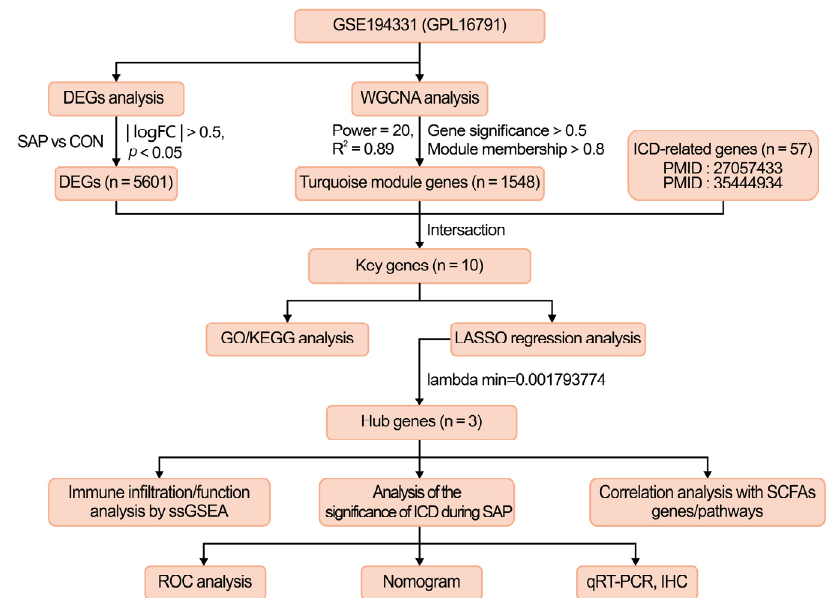
Figure 10. The study flowchart of the whole experiment. GSE, gene expression omnibus series; WGCNA, weighted gene co-expression network analysis; DEGs, differentially expressed genes; ICD, immunogenic cell death; GO, Gene Ontology; KEGG, Kyoto Encyclopedia of Genes and Genomes; LASSO, least absolute shrinkage and selection operator; SCFAs, short-chain fatty acids; ssGSEA, single sample gene set enrichment analysis; IHC, immunohistochemistry.